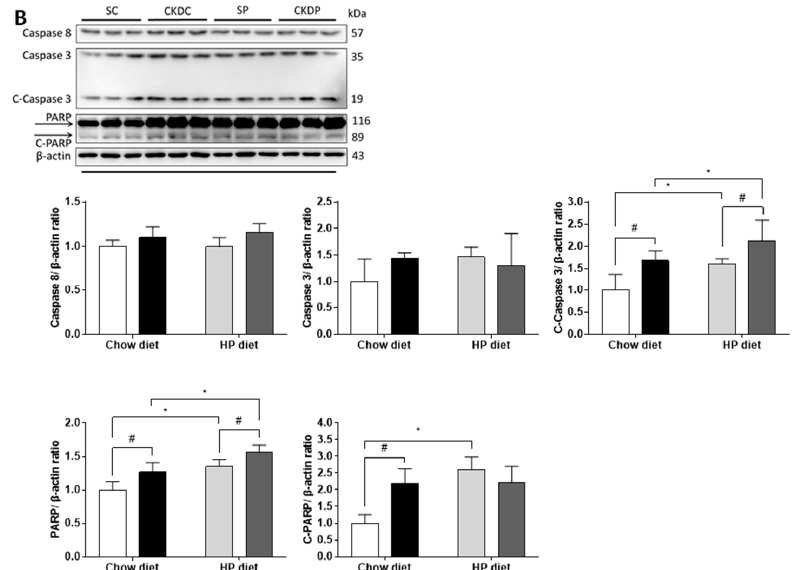
Figure 6. Protein expressions of testicular ( A ) extrinsic and ( B ) intrinsic apoptosis pathway markers in high phosphorus diet-fed mice with or without CKD induction. Data are expressed as the mean ± SD. # indicates a significant difference between the sham-operated and CKD-induced groups (SC vs. CKDC and SP vs. CKDP); * indicates a significant difference between the chow diet and HP diet groups (SC vs. SP and CKDC vs. CKDP).